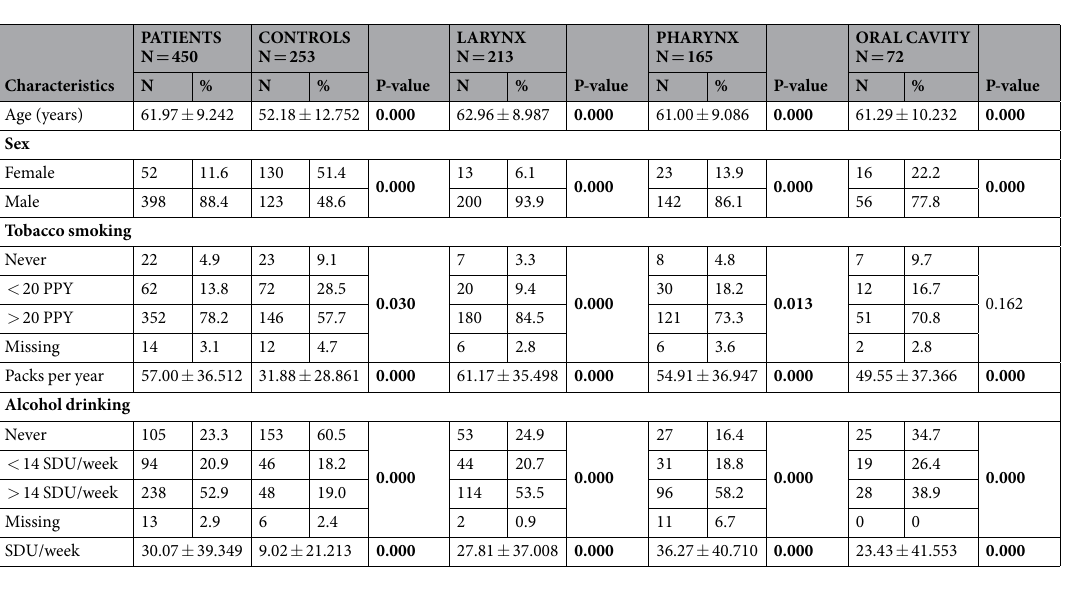
Table 2. Descriptive case-control study. P-values related to controls. Statistically significant results in